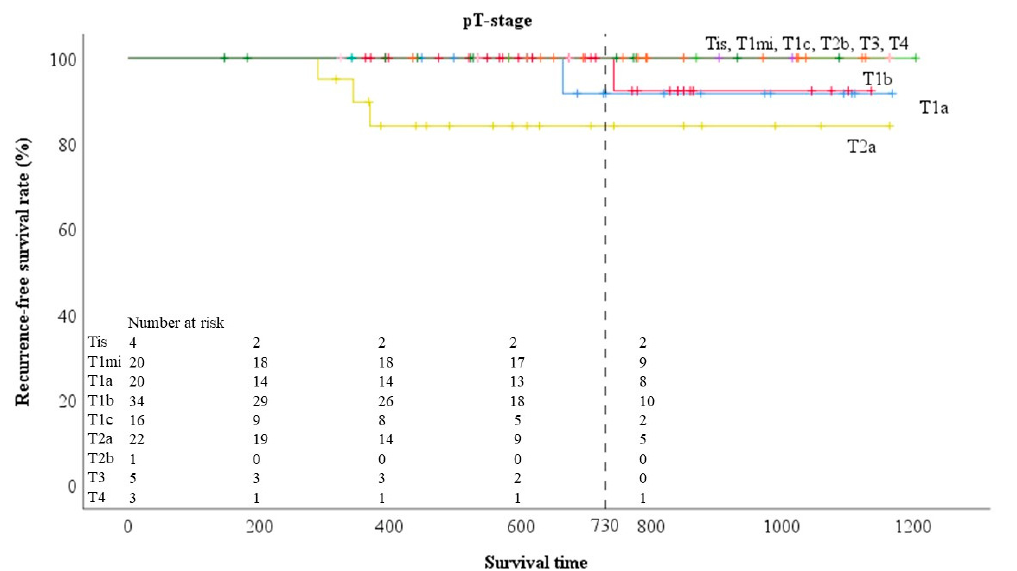
Figure 2. Prognosis by pathological T-factor in 125 adenocarcinomas. Table 6. Comparison of measurement diameter between adenocarcinoma and all histological types.